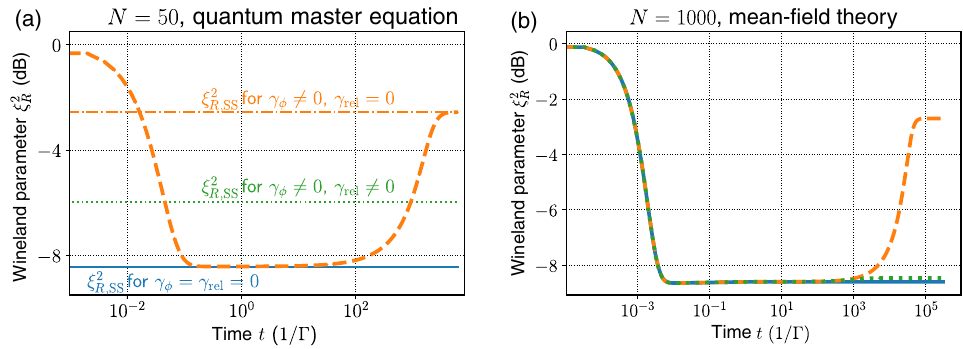
FIG. 6. Time evolution of the Wineland spin-squeezing parameter ξ 2 the time axis). (a) Wineland parameter calculated using the quantum master equation (11) for weak local dephasing, r ¼ 1 . 0 , and N ¼ 50 spins (thick dashed orange line, γ ϕ = Γ ¼ 0 . 005 , γ indicated by the thin dash-dotted orange line. Local dephasing deteriorates the amount of steady-state spin squeezing compared to an ideal system without local dissipation (solid blue line, γ ϕ = Γ ¼ γ partially restores the steady-state spin squeezing (dotted green line, γ ϕ = Γ ¼ 0 . 005 , γ transient state is strongly spin squeezed even in the presence of local dissipation since the collective dissipator on a short timescale ∝ 1 =N Γ , whereas the system approaches its steady state on a longer system-size-dependent timescale ∝ N= γ ϕ . (b) Wineland parameter calculated using the mean-field equations of motion detailed in Appendix B for N ¼ 1000 spins and the same sets of dissipation rates as in